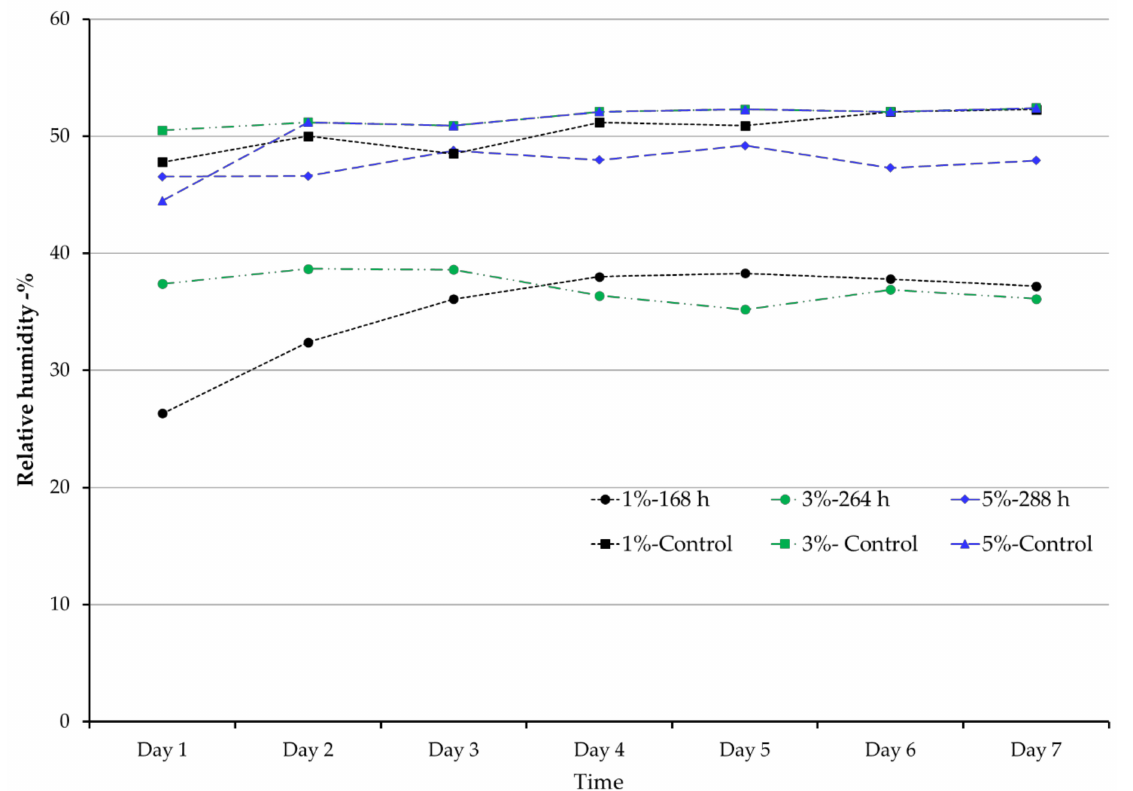
Figure 3. Average relative humidity at different oxygen levels within the first seven days of the maximum duration for each treatment and its